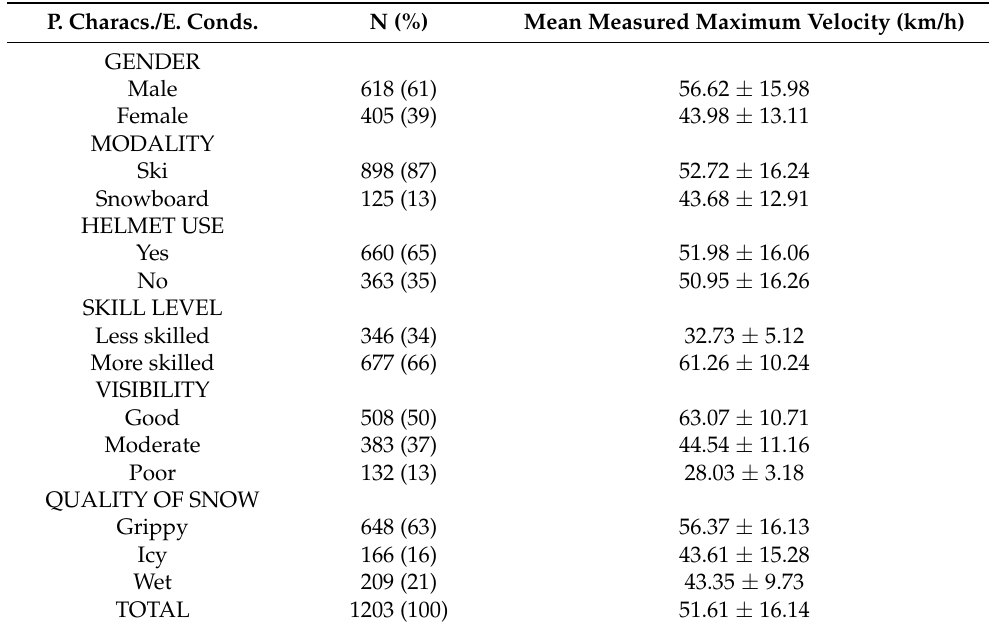
Table 1. Personal characteristics, environmental conditions and mean values ( ± SD) of measured maximum